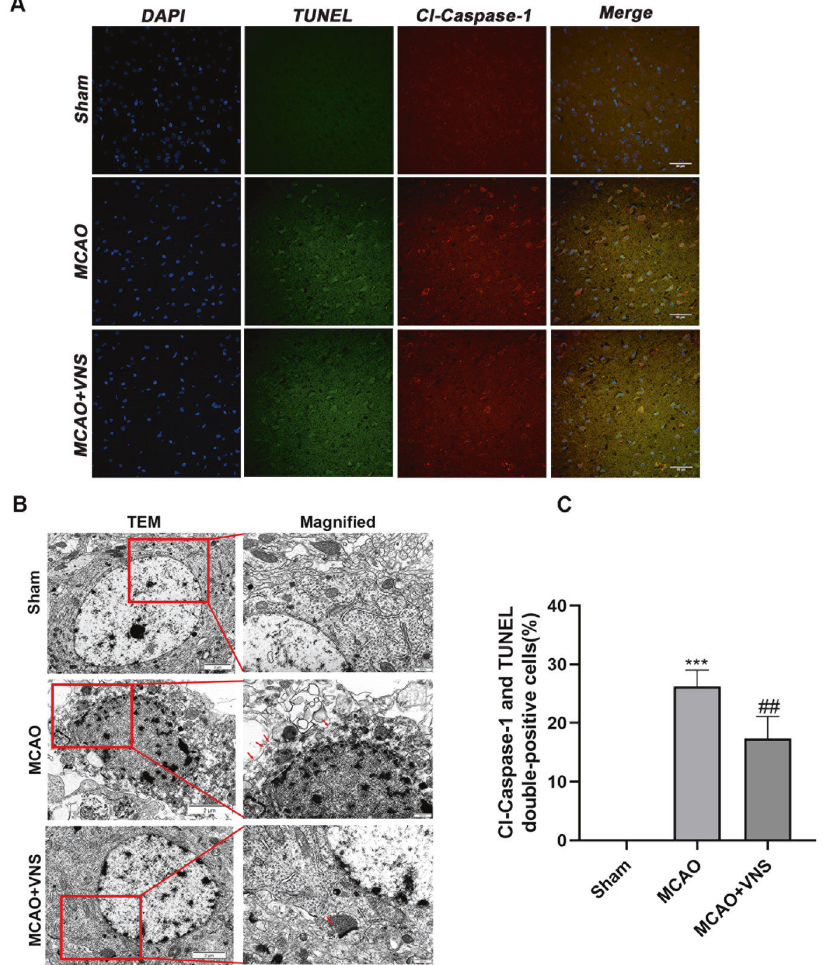
Fig. 3 VNS suppressed cellular pyroptosis following cerebral ischemia and reperfusion injury. A , C VNS decreased the number of TUNEL (green) and Cl-Caspase-1 (red) double-positive cells when compared to the MCAO group. Scale bar = 50 μ m. B Representative transmission electron microscopy images of neurons in the ischemic penumbra. Red boxes: magni fi ed area, red arrowhead: membrane pores. *** P < 0.001 versus the sham group, ## P < 0.01 versus the MCAO